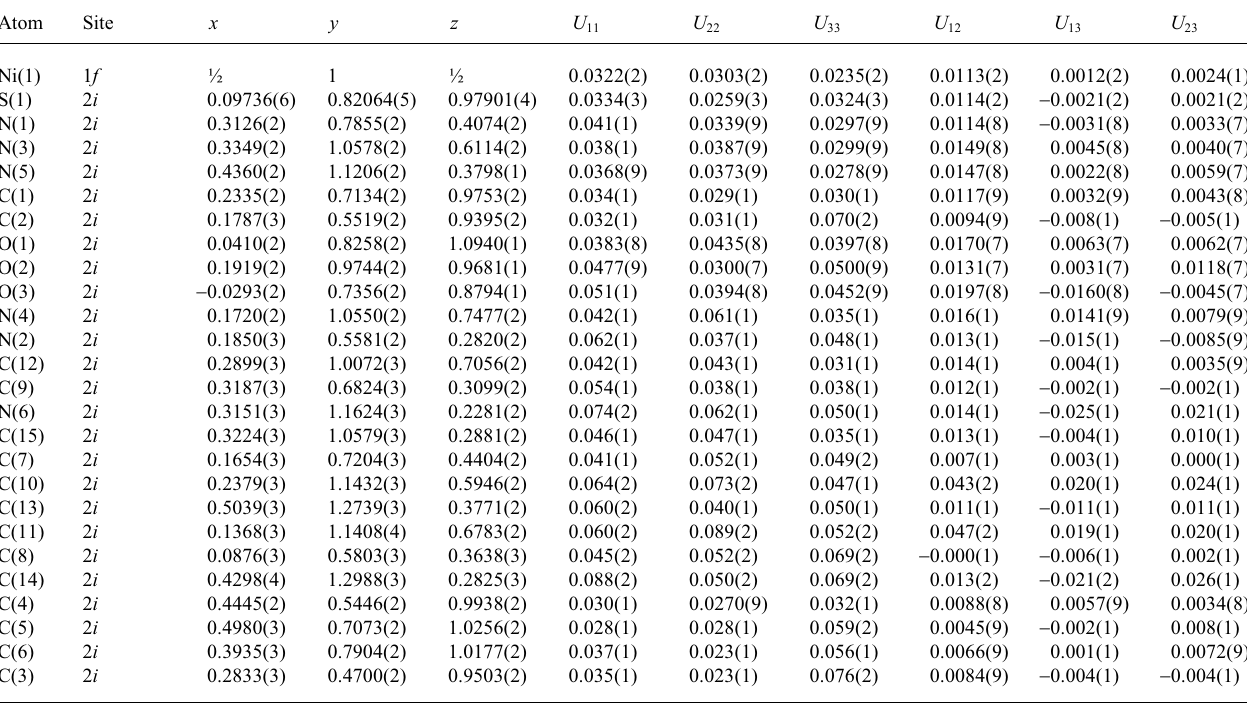
Table 3. Atomic coordinates and displacement parameters (in Å 2